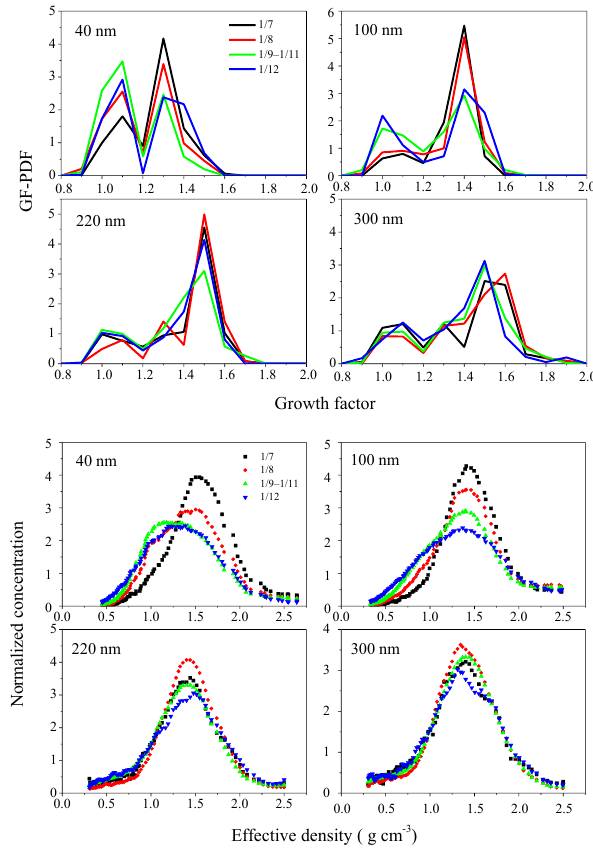
Figure 6. Evolutions of particle hygroscopic growth factor and effective density for different sizes during the representative PM